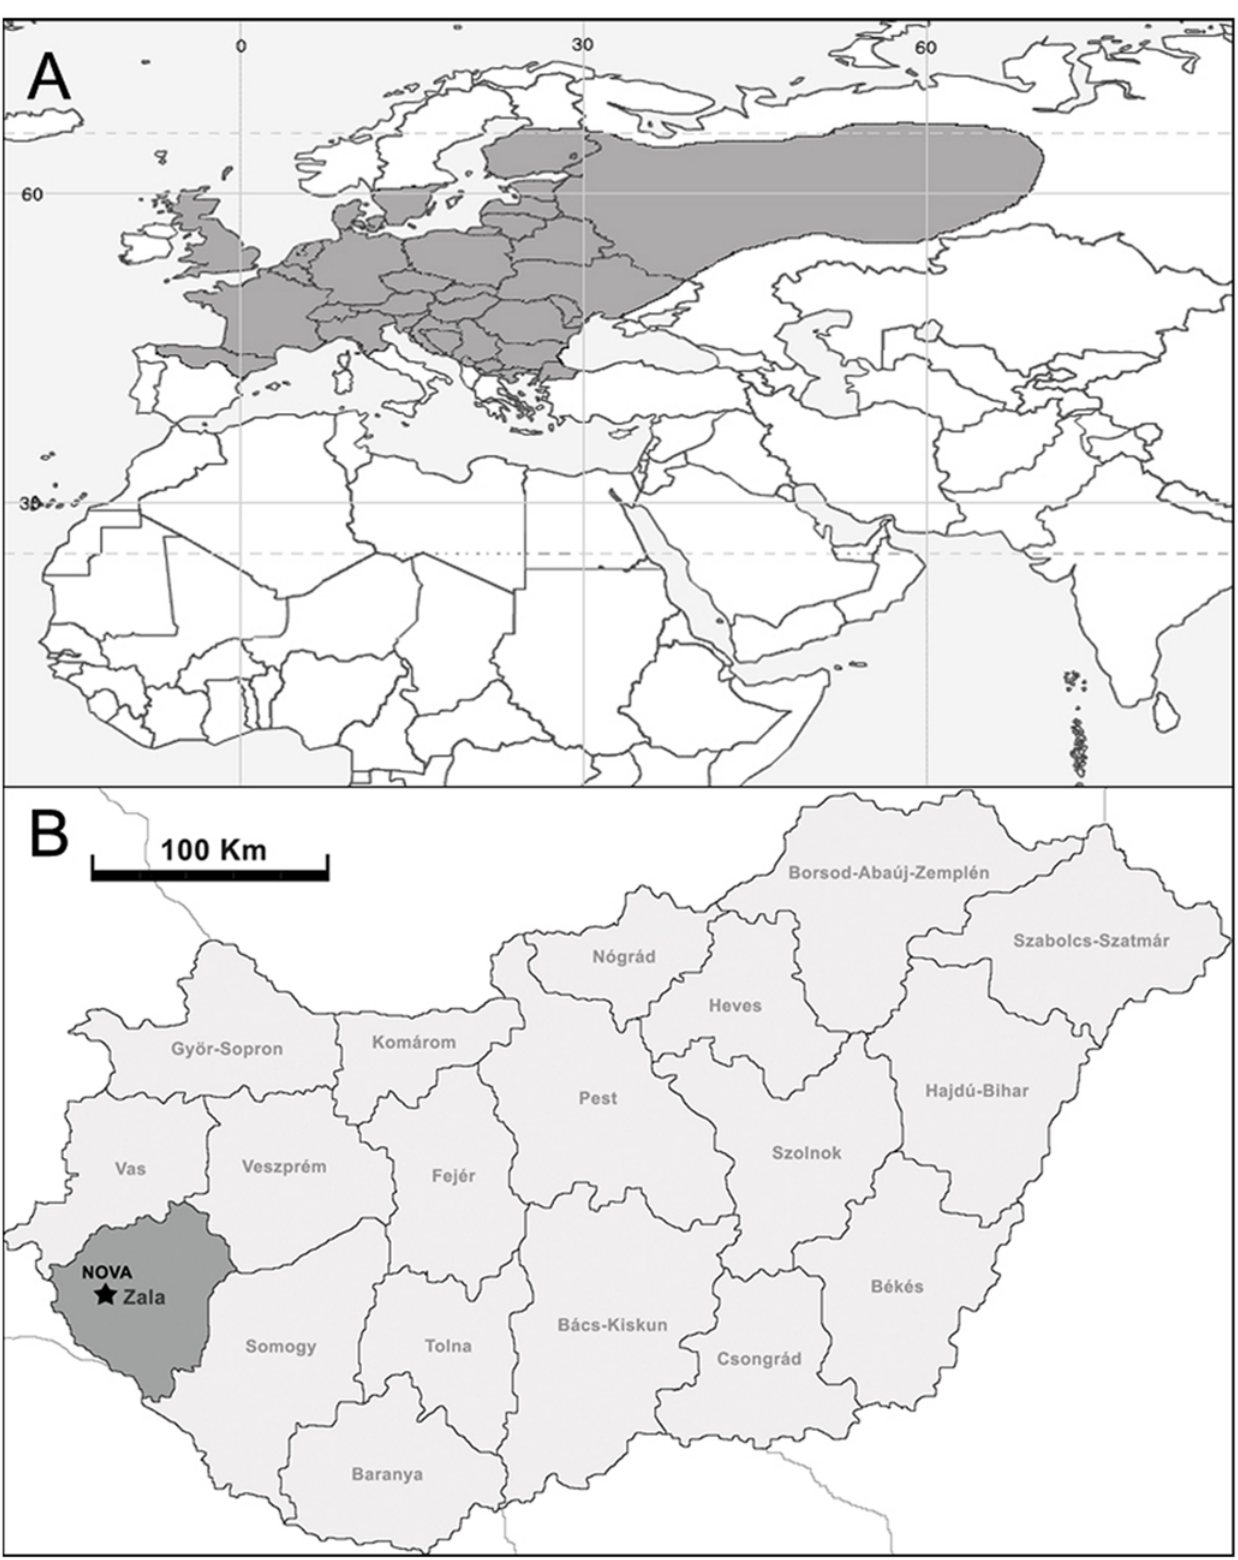
Figure 1. Map, showing the (A) distribution of the European common mole ( Talpaeuropaea ) in western Eurasia and (B) capture site of the host specimen of Nova virus in Hungary. European common moles are distributed throughout temperate Europe and western Russia. Nova virus RNAs were amplified from liver tissue of a European common mole, captured near Nova (star), in Zala County, Hungary, in July 1999.